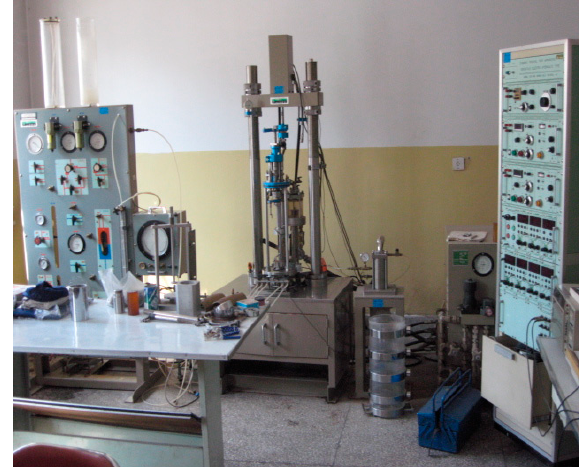
Figure 1. Triaxial equipment for measuring soil properties.